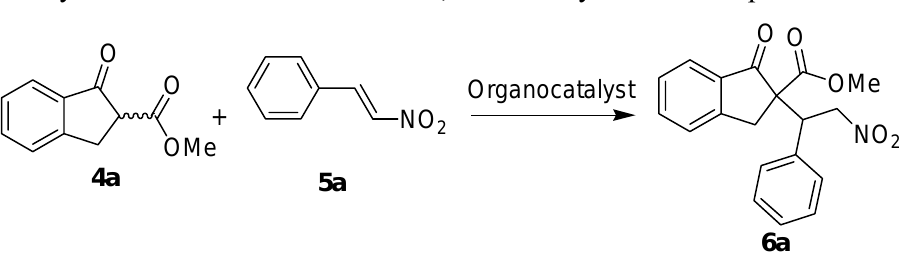
Figure 1. Enantio- and diastereoselectivities in the Michael reaction using different